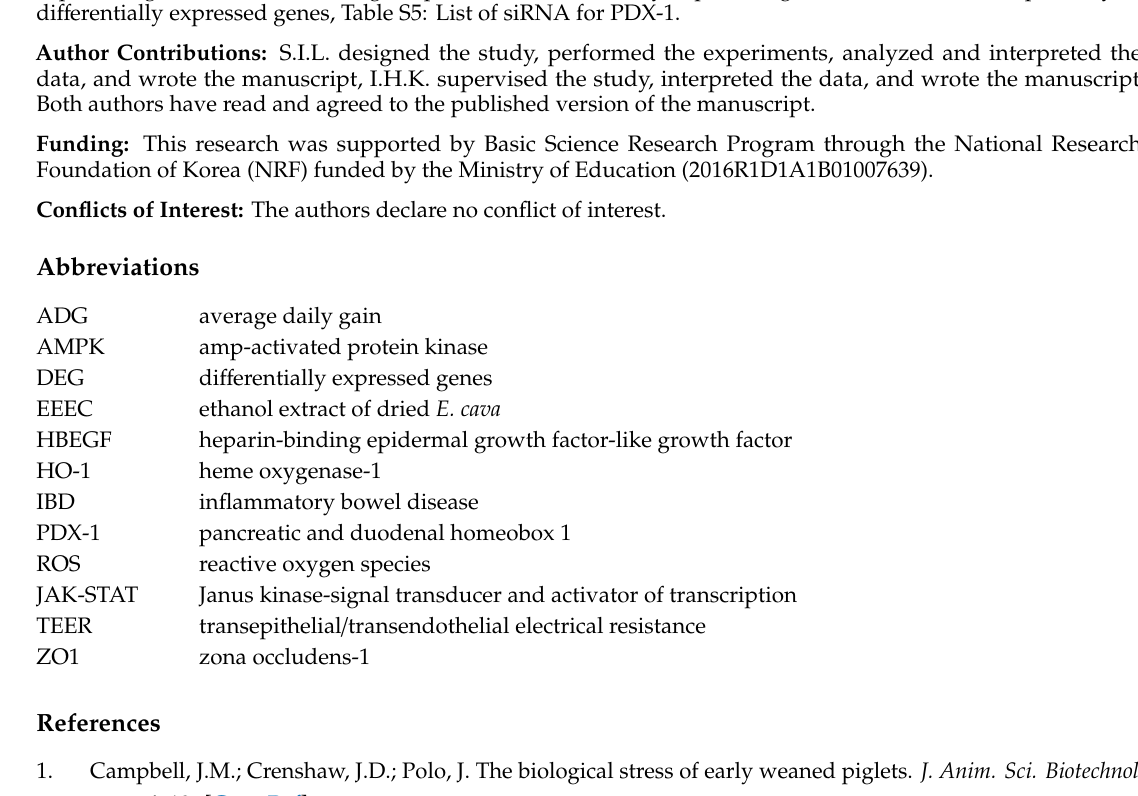
Table S1: Molecular functions of di ff erentially expressed genes, Table S2: Cellular component of di ff erentially expressed genes, Table S3: Biological process of di ff erentially expressed genes, Table S4: KEGG pathway of di ff erentially expressed genes, Table S5: List of siRNA for PDX-1. Author Contributions: S.I.L. designed the study, performed the experiments, analyzed and interpreted